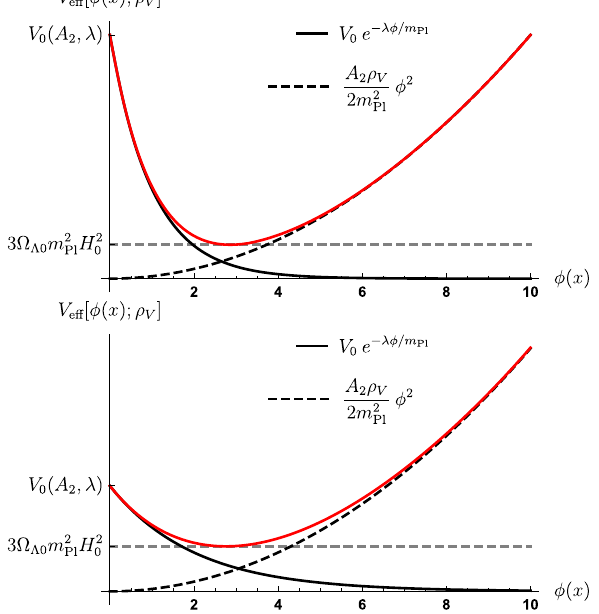
Fig. 1 The effective potential in Eq. (4) is plotted with its components for two different sets of parameter values for λ and A 2 , while the param- eter V 0 varies as a function of A 2 and λ such that the effective potential of the minimum in vacuum equals 3 (cid:9) (cid:10) 0 m 2 Table 1 Here, Eqs. (5) and (8) are given for different